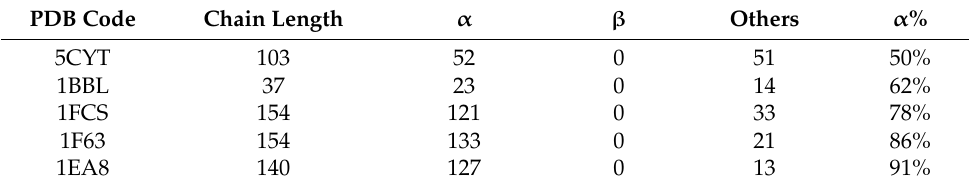
Table 1. Structural information of all- α protein samples.